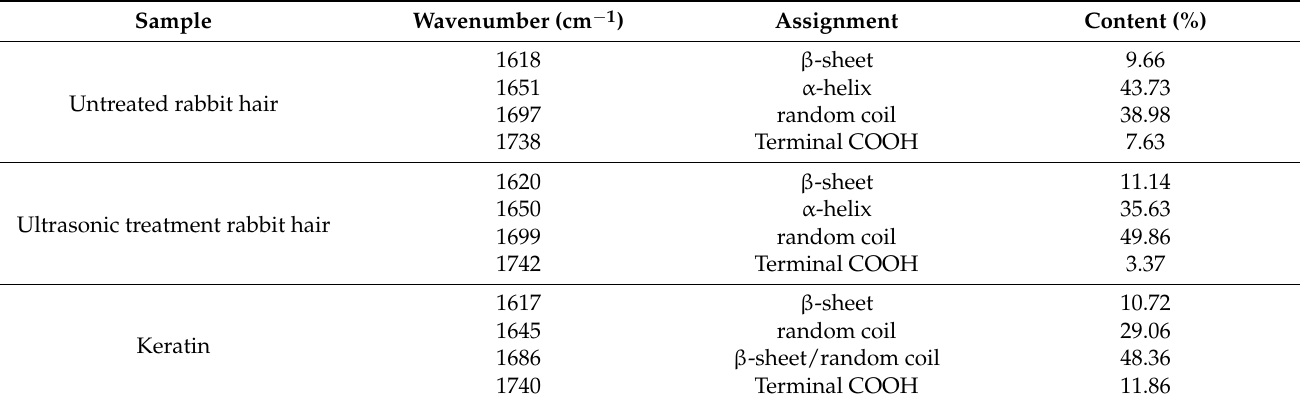
Table 2. Contents of α -helix and β -sheet in various